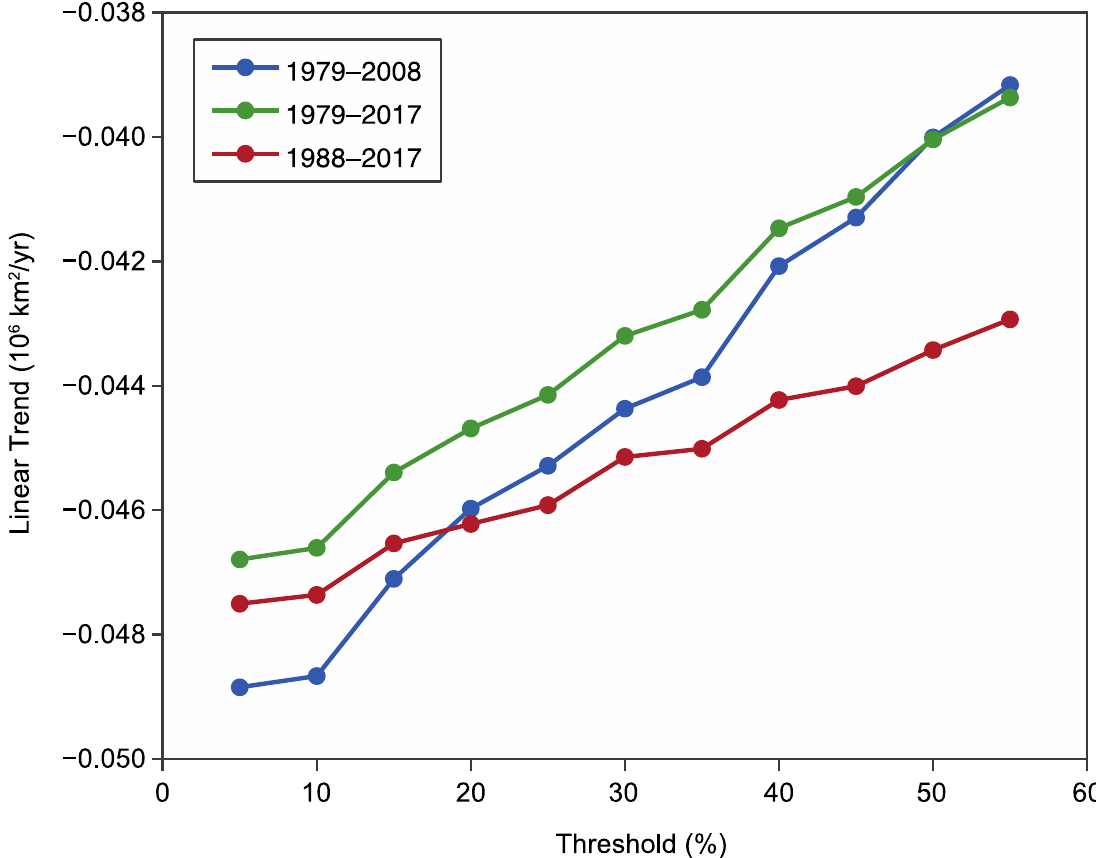
Figure 6. Optimized slopes of linear regression fits to the SIE annual maximum time series.